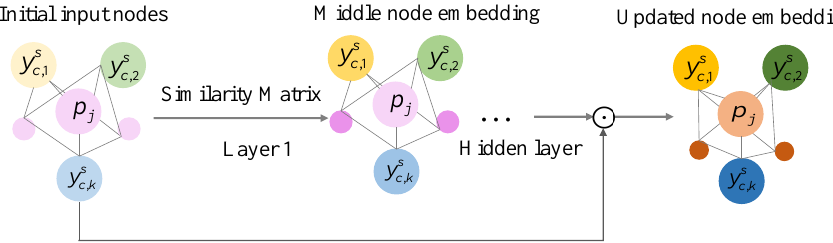
Figure 4. The construction of graph convolutional network (GCN) designed for few-shot object detection task (cid:12) means multiplication